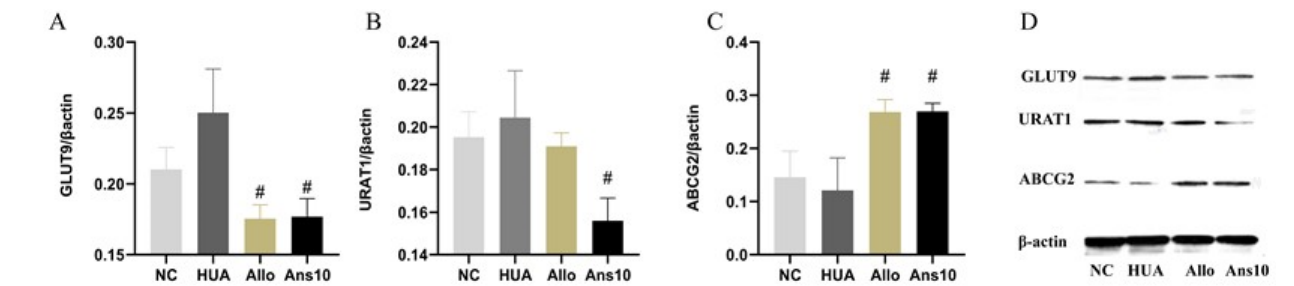
Figure 2. Effect of anserine on kidney urate transport-related proteins. ( A ) GLUT9; ( B ) URAT1; ( C ) ABCG2; and ( D ) Western blot result of GLUT9, URAT1 and ABCG2 protein in each group. # p < 0.05 indicates that the difference is significant when compared to the HUA group.